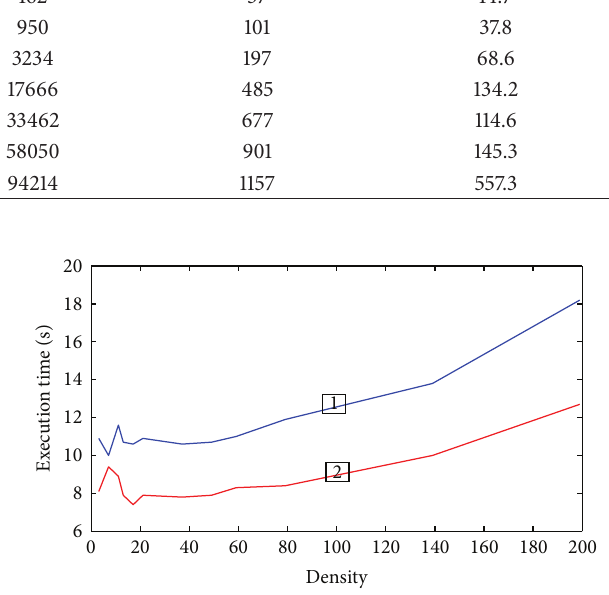
Figure 2: Sensitivity to density of two sample problems: dataset 1 and dataset 2 from Table 1.